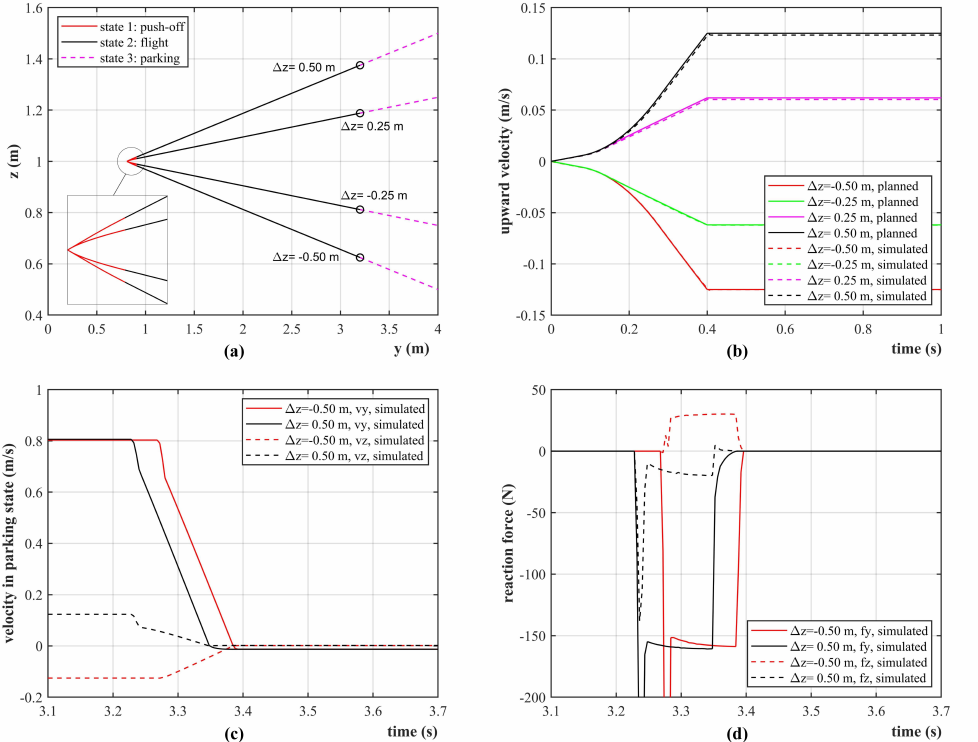
Figure 10. Motion planning and control of the PFP locomotion strategy targeted at various docking points. ( a ) trajectories of the COM. ( b ) upward velocities. ( c ) velocities during the parking phase. ( d ) reaction forces during the parking